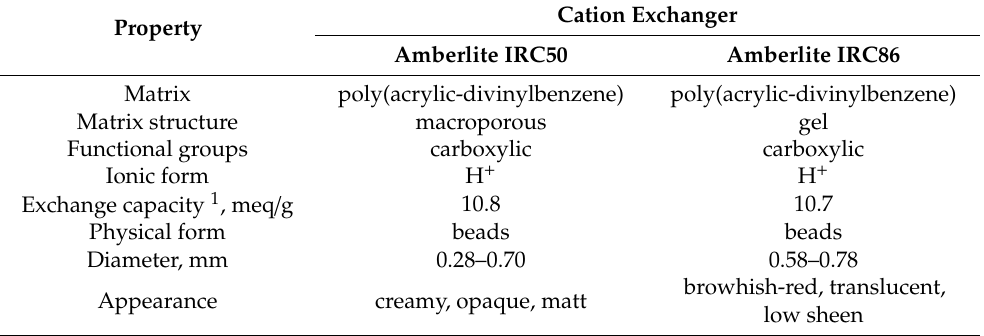
Table 1. Characterization of polymeric base